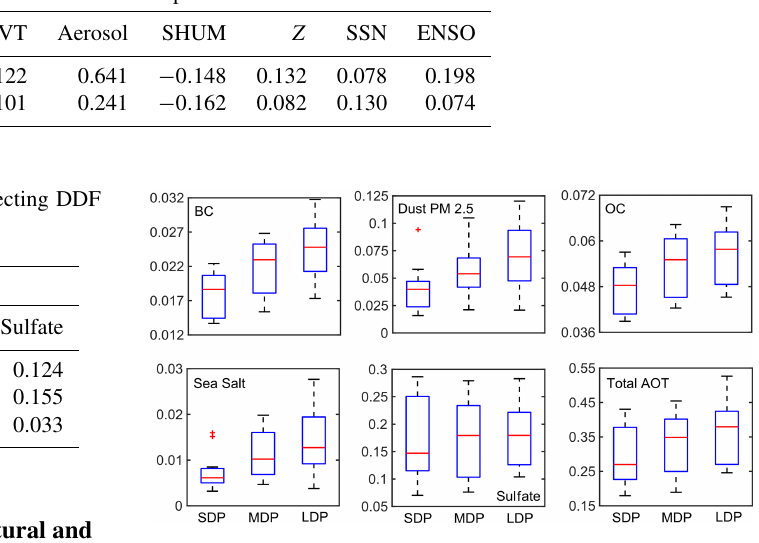
Table 2. MLR coefficients for all general factors affecting DDF for region 1a, Lucknow and region 3. Region Components T2m VT Aerosol SHUM